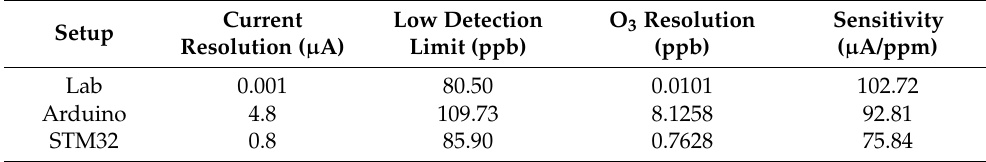
Table 1. Current resolution, low detection limits, O 3 resolution and sensitivity of Co 3 O 4 sensor